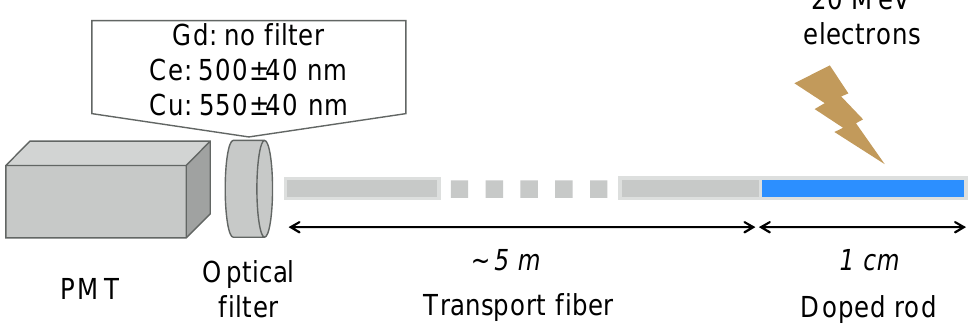
Figure 1. Schematic overview of the setup, where radiation-induced luminescence (RIL) in the doped rods are transported to a photomultiplier tube (PMT) through an optical